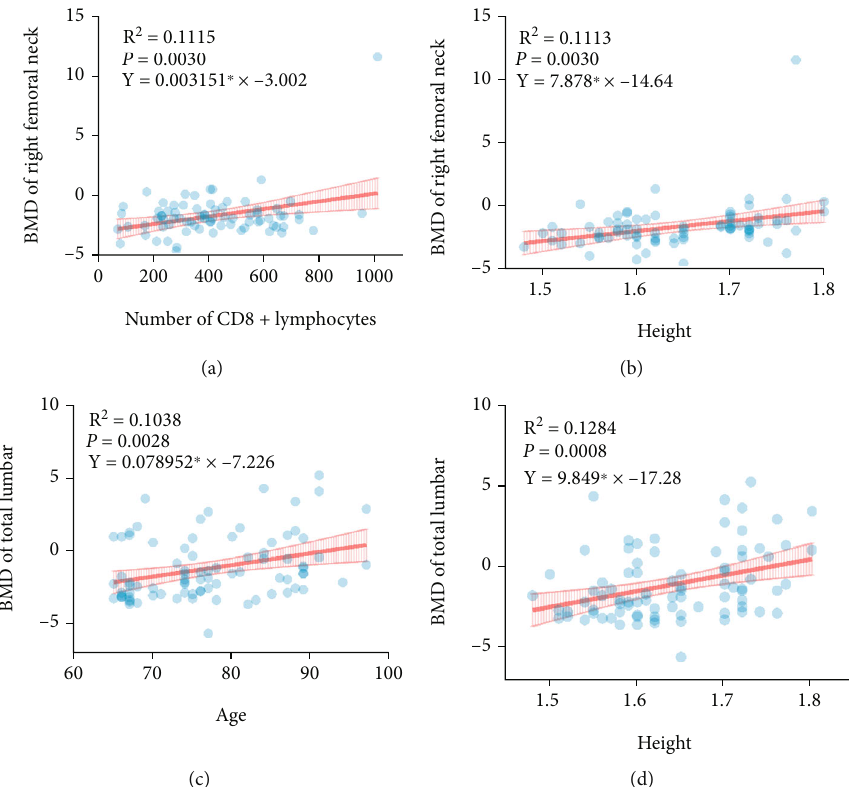
Figure 3: Linear regression analysis for evaluating the relationship among BMD levels, height, age, and absolute counts of lymphocyte subsets in patients with senile OP. Linear regression analysis of the relations between the right femoral neck BMD values and CD8 + T lymphocyte counts (a) or height (b) and the BMD of total lumbar and age (c) or height (d). P value < 0.05 was considered a signi fi cant linear